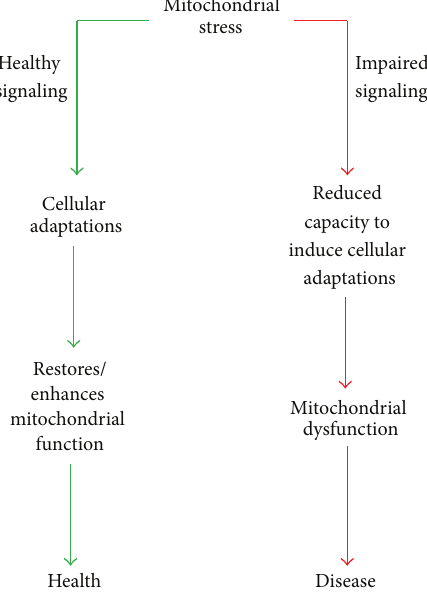
Figure 1: Hypothesis of responses to mitochondrial stress in health and disease. In times of mitochondrial stress, signals are sent to the cell which promote cellular adaptations that restore or possibly enhance mitochondrial function to maintain health (green arrows). In situations where mitochondrial stress signals are not relayed to other parts of the cell or the cell does not respond stress signals (red arrows), there is a failure for cellular adaptations which may consequently result in mitochondrial dysfunction and the development of